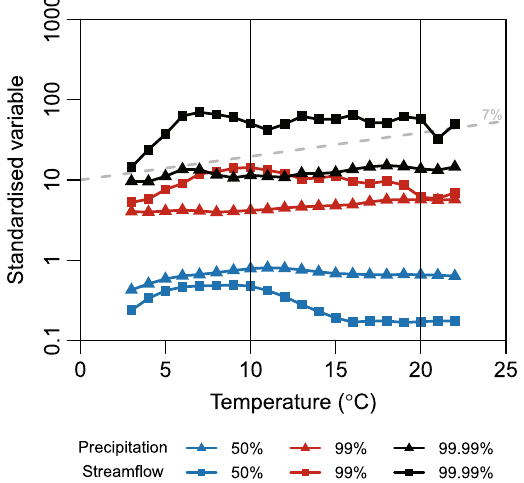
Figure 2. Precipitation and streamflow percentiles with temperature for South East Australia. Precipitation and streamflow aggregations have been divided by the mean value at that gauge. The 50 th and 99 th percentile were calculated empirically from the data using 2 °C temperature bins, overlapping by 1 °C while the 99.99 th percentile was calculated from a fitted generalized pareto distribution to the upper 1% of the data. As a reference, the grey dashed line represents the approximate Clausius-Clapeyron scaling of 7%. Vertical black lines represent the temperature range used in subsequent analysis. Figure was created using the statistical software ‘R’ 61